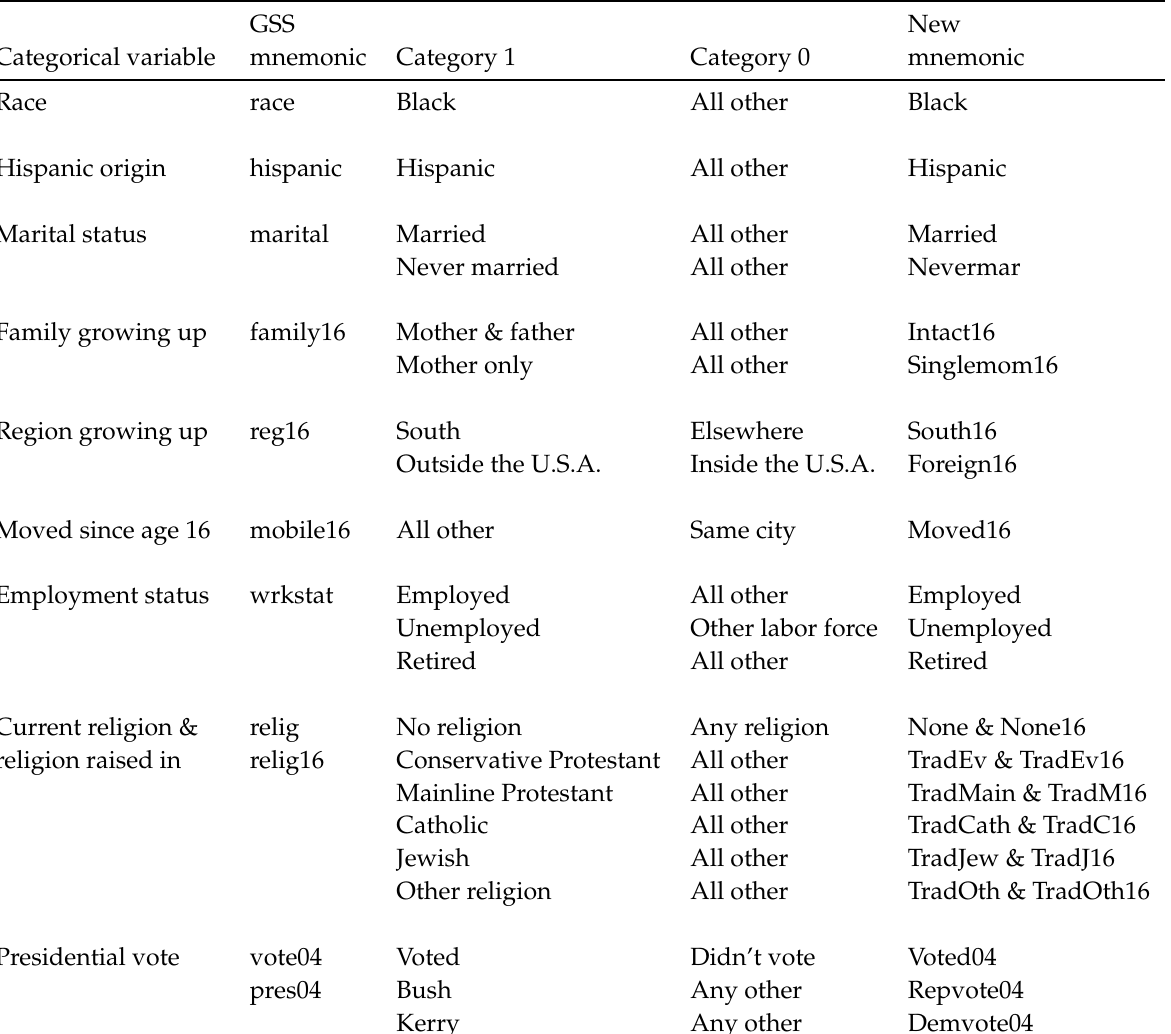
Table 1: Dichotomies formed from categorical